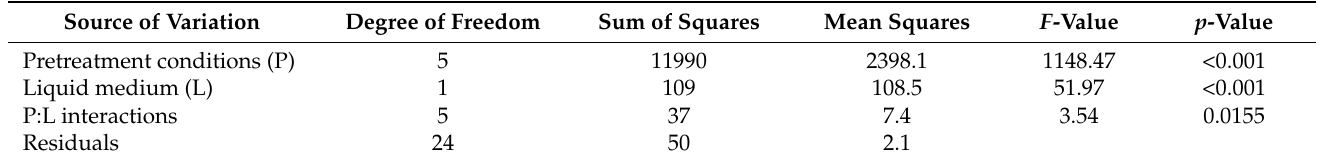
Table 5. Two-way ANOVA for enzymatic digestibility in saccharification trials with pretreatment solids suspended in either sodium citrate buffer or pretreatment liquids for all the pretreatment conditions.